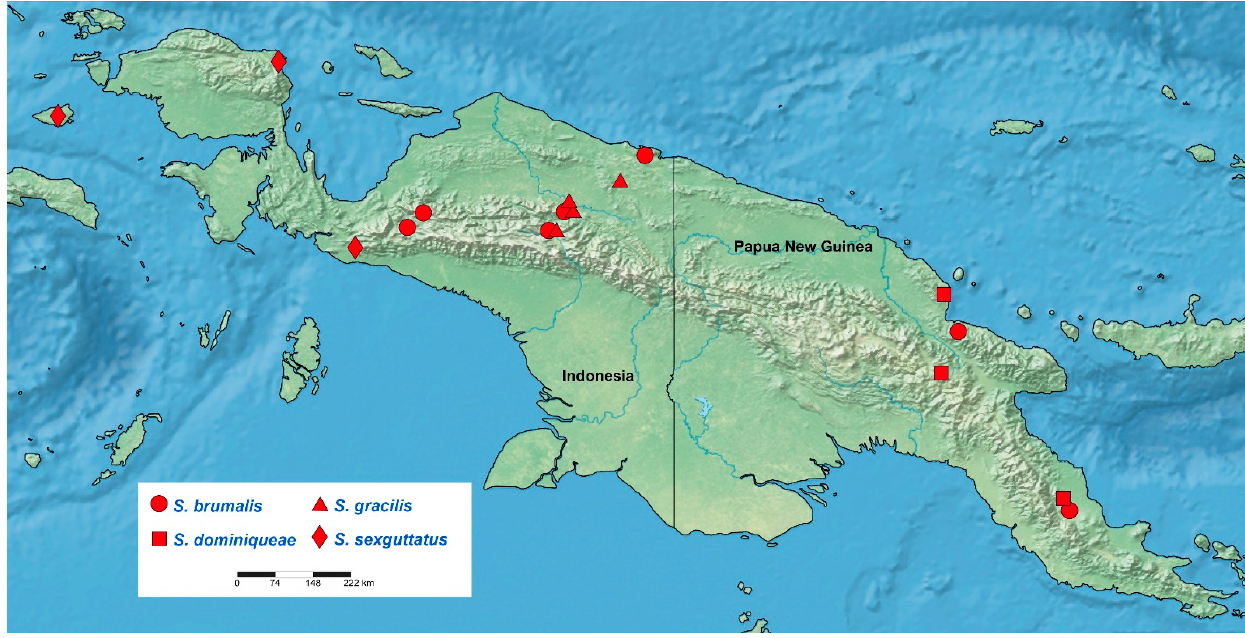
Figure 17. Known distribution of Sigicoris stat. nov.